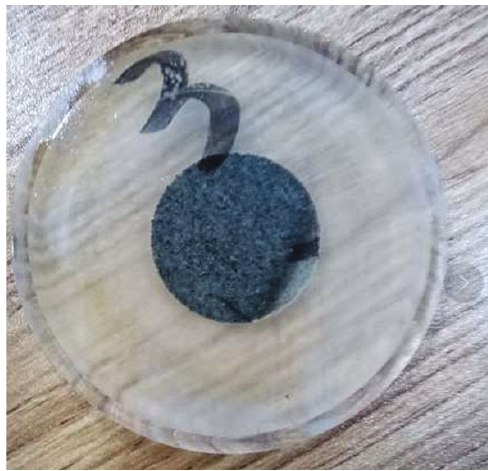
Figure 4: Core slice for PTM permeability